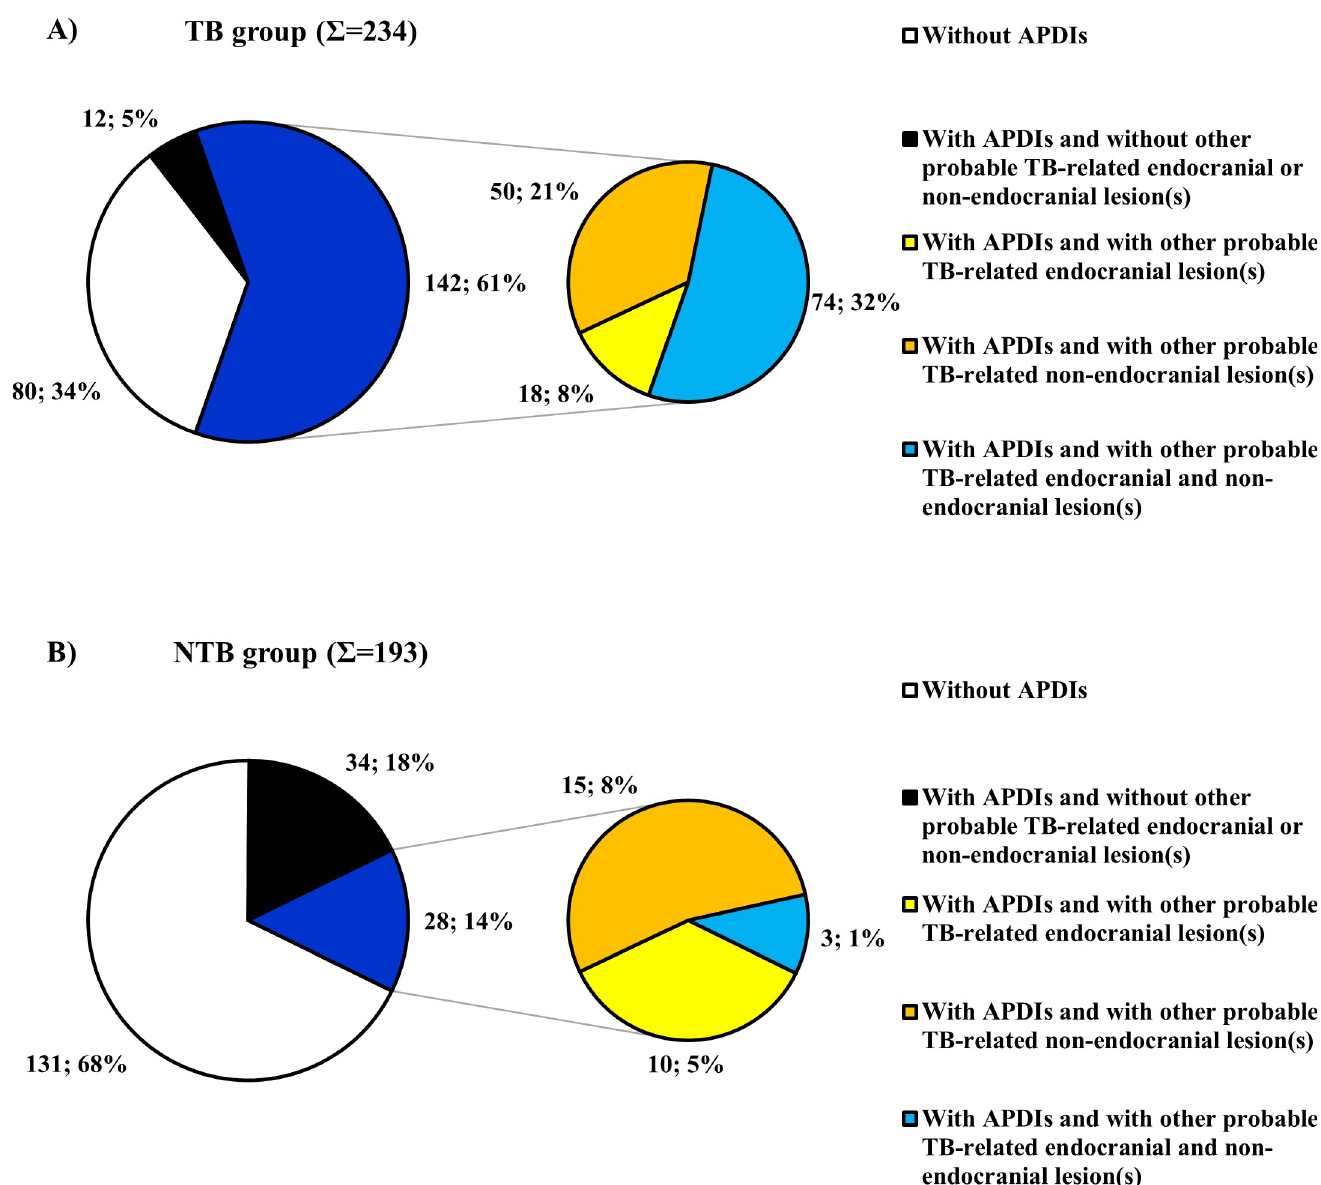
Fig 4. Distribution of the selected individuals from the Terry Collection by the presence of APDIs (considering the co-occurrence of APDIs with other probable TBM-related endocranial lesion types and/or with possible TB-associated non-endocranial lesion types). A) Distribution of individuals who died of TB; and B) Distribution of individuals who died of NTB causes. (In both the TB group (A) and NTB group (B), the larger pie chart shows the distribution of all individuals by the presence of APDIs (i.e., not present (white), present but alone (black) or present in association with other likely TB-related lesion(s) (dark blue)). The smaller pie chart shows the distribution of individuals displaying APDIs in association with other probable TB-related lesion(s) by the type of the lesion(s) simultaneously occurring with APDIs (i.e., besides APDIs, only other probable TBM-related endocranial lesion(s) are present (yellow), besides APDIs, only possible TB-associated non-endocranial lesion(s) are present (orange) or besides APDIs, both other probable TBM-related endocranial lesion(s) and possible TB-associated non-endocranial lesion(s) are present (light blue)). The percentage values were calculated with respect to the total number of individuals in both the TB group (N TB = 234) and NTB group (N NTB =